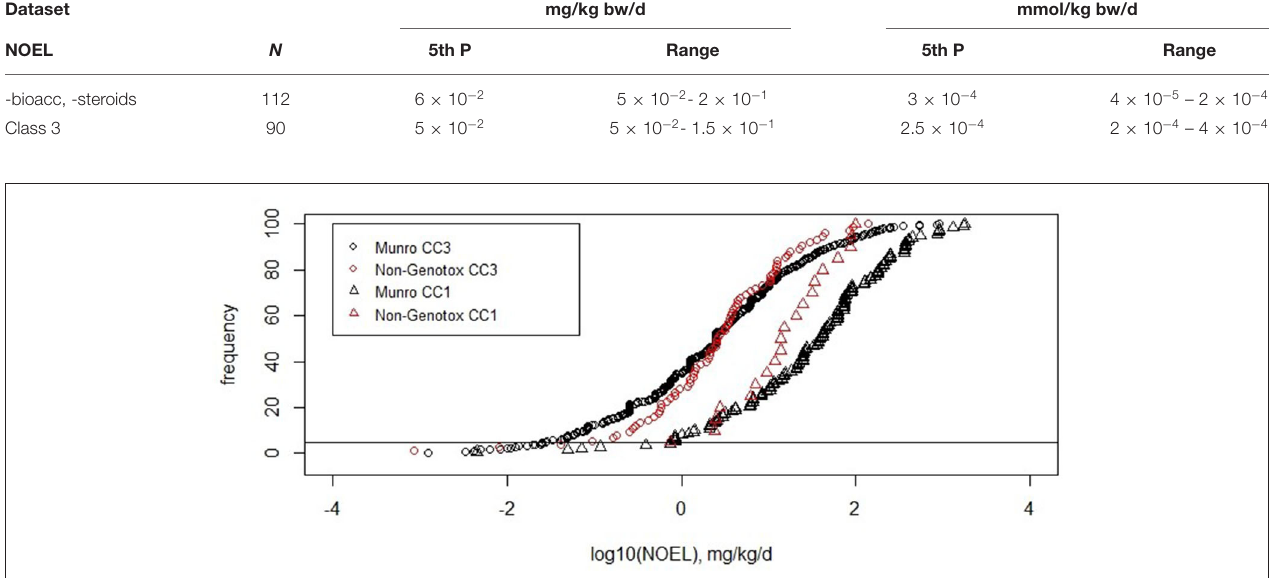
TABLE 4 | Fifth percentiles of non-genotoxic datasets and original datasets by Munro for Cramer class 3 with respective ranges after randomly removing 5%. Dataset